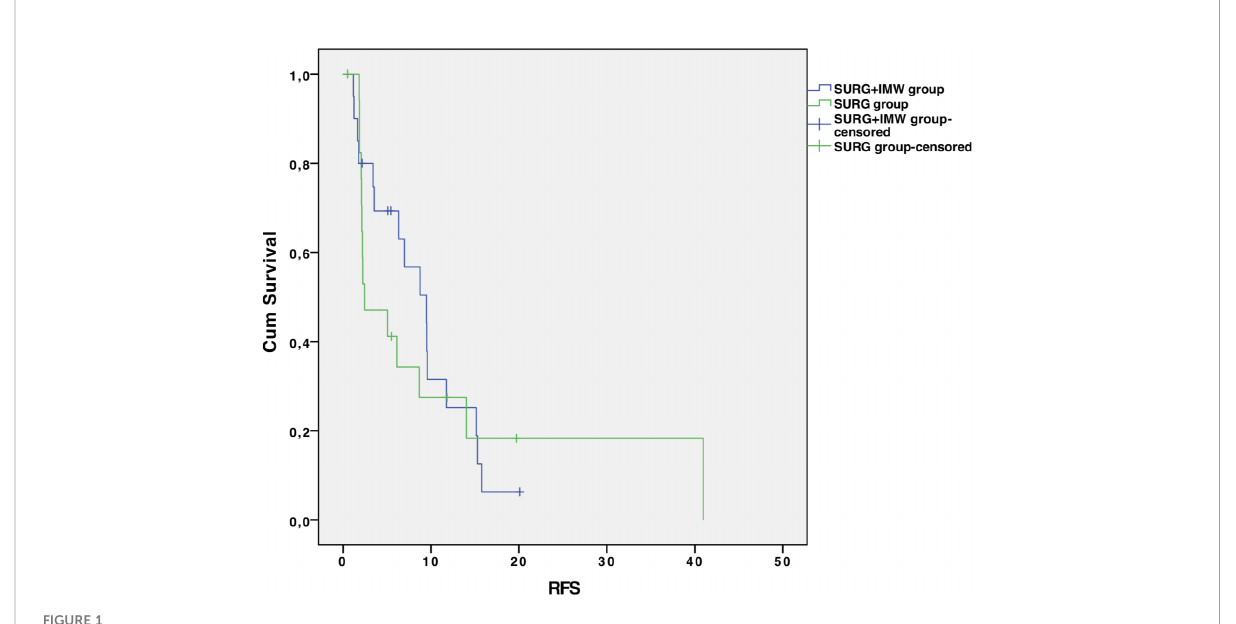
FIGURE 1 Disease-free survival in the two groups.